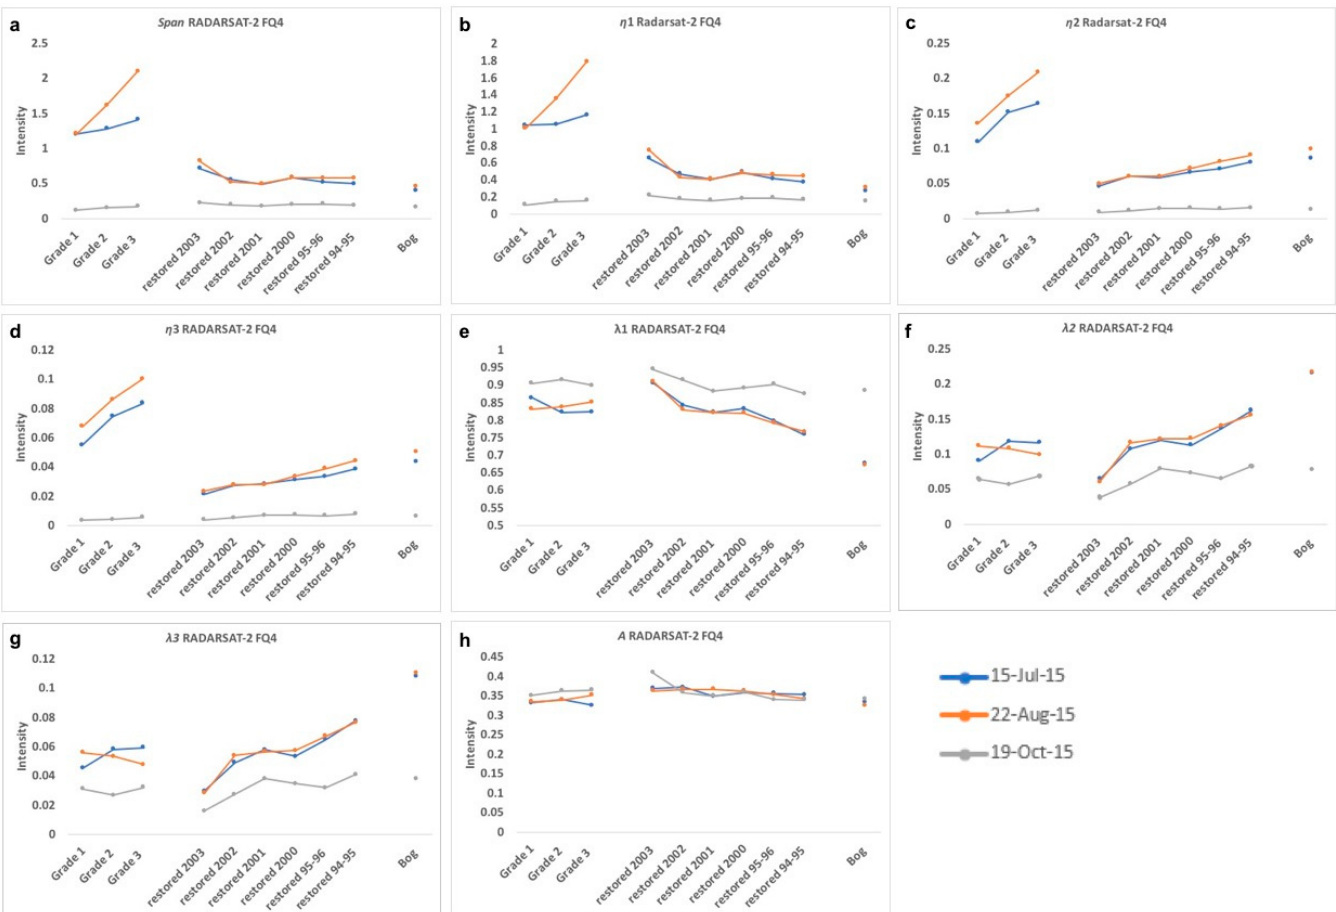
Figure 4. RADARSAT-2 FQ4 spectral signatures for natural shrub bog, restored peat, and actively harvested peat. ( a ) Total power (span), ( b ) dominant eigenvalue, ( c ) secondary eigenvalue, ( d ) tertiary eigenvalue, ( e ) normalized dominant eigenvalue, ( f ) normalized secondary eigenvalue, ( g ) normalized tertiary eigenvalue, and ( h ) anisotropy.